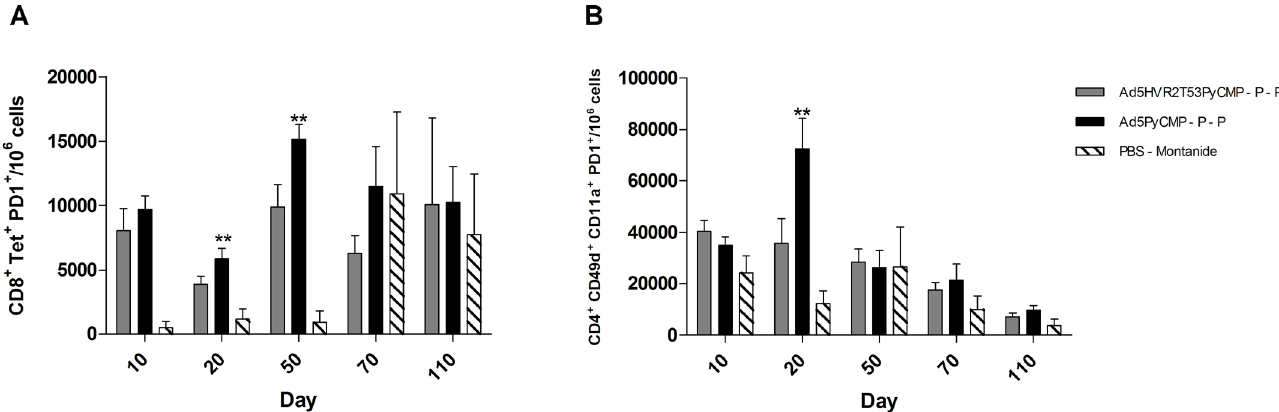
Fig 9. T cell PD-1 expression in PBMC induced by the vaccination regimen based on the Ad5HVRT53PyCMP vector. CB6F1/J (n = 5 per group) mice received the regimens described in Fig 6. PBMC derived from mice whole blood were obtained during the immunization schedule on the days stated in the graph and were processed by flow cytometry, (A) CD8+ Tetramer+ T cells PD-1 expression (B) CD4+ CD11+ CD49d+ T cells PD- 1 expression. The results are presented as the number of PD-1 positive cells present in 10 6 PBMC. The differences between the groups were analyzed by Kruskal-Wallis test with Dunns post-test, significant statistical differences between the groups are denoted by ** (p < 0.01).